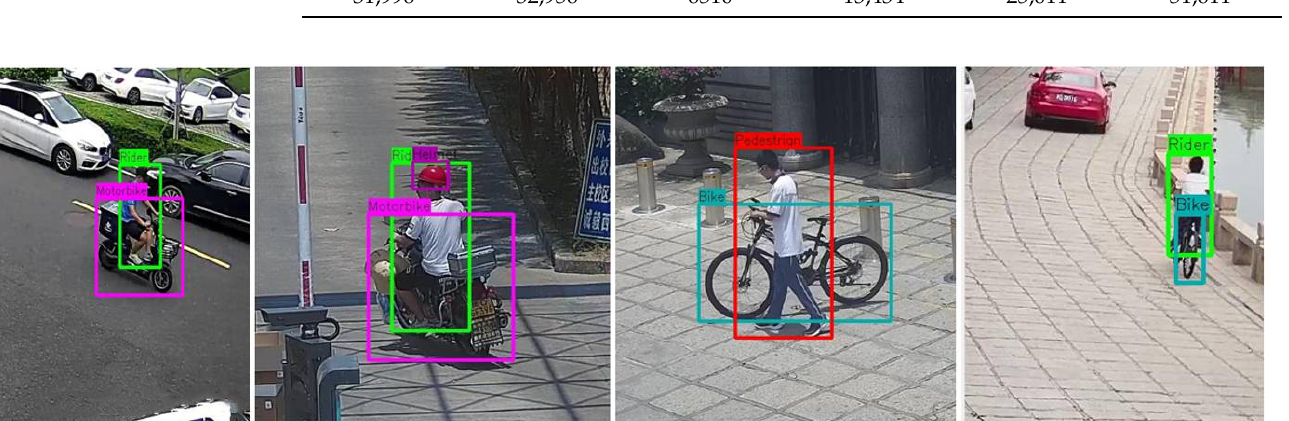
Figure 4. Categories in RIDER.